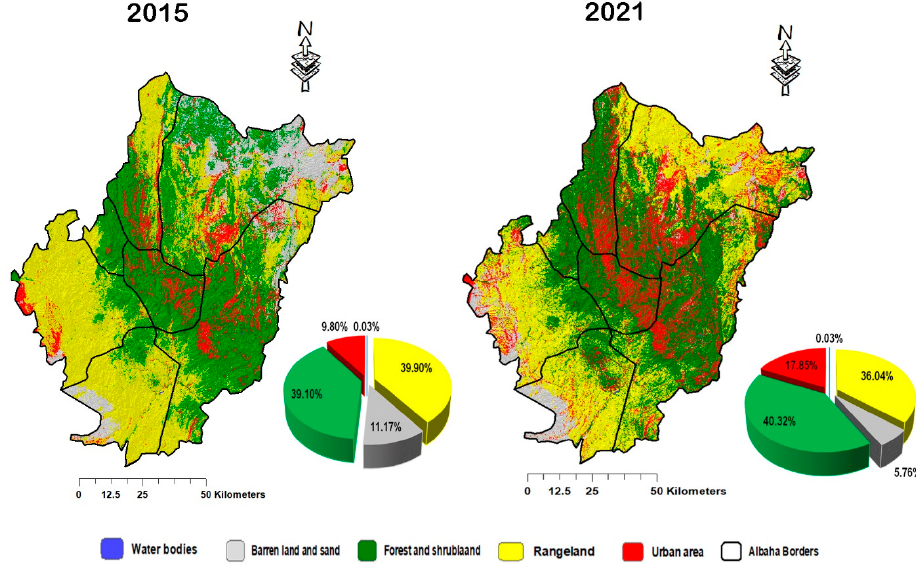
Figure 4. Land use land cover change maps for the years: 1985, 1990, 1995, 2000, 2015, and 2021.